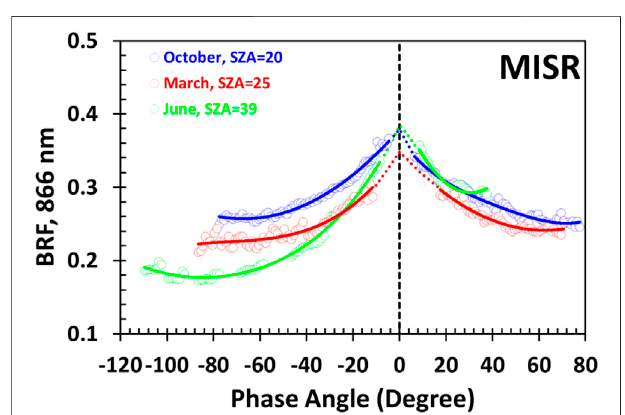
FIGURE 8 | Angular signatures of NIR re fl ectance of Amazonian forests in March (5 Mar to20Mar), June(25 Junto10Jul),and October(15 Oct to30 Oct) derived from MISR